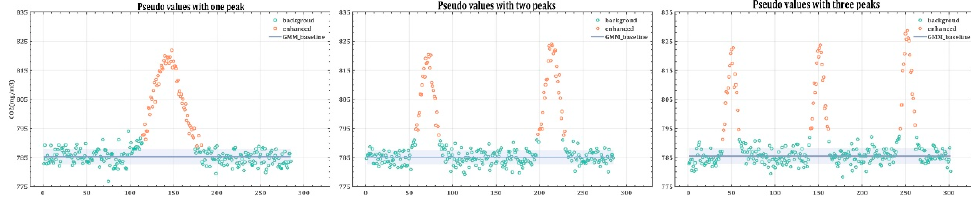
Figure 3. Gaussian mixture model clustering results.